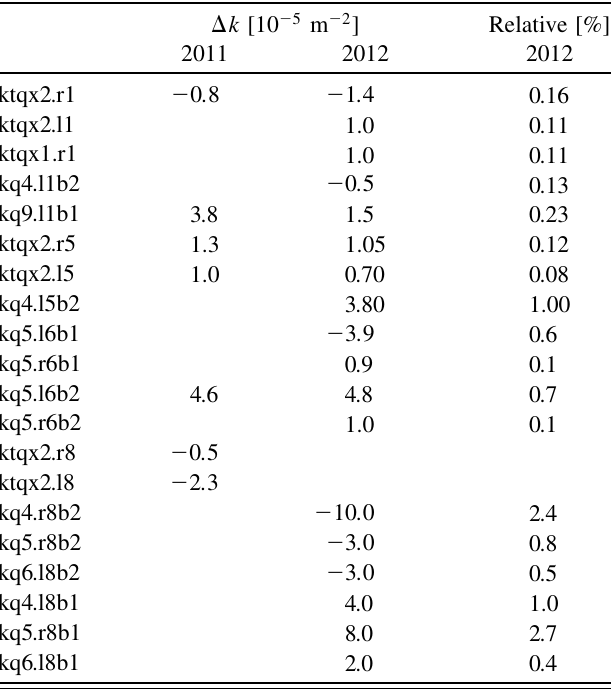
TABLE II. Strength of local corrections used in 2011 and 2012. Relative values for the 2012 case are also shown.